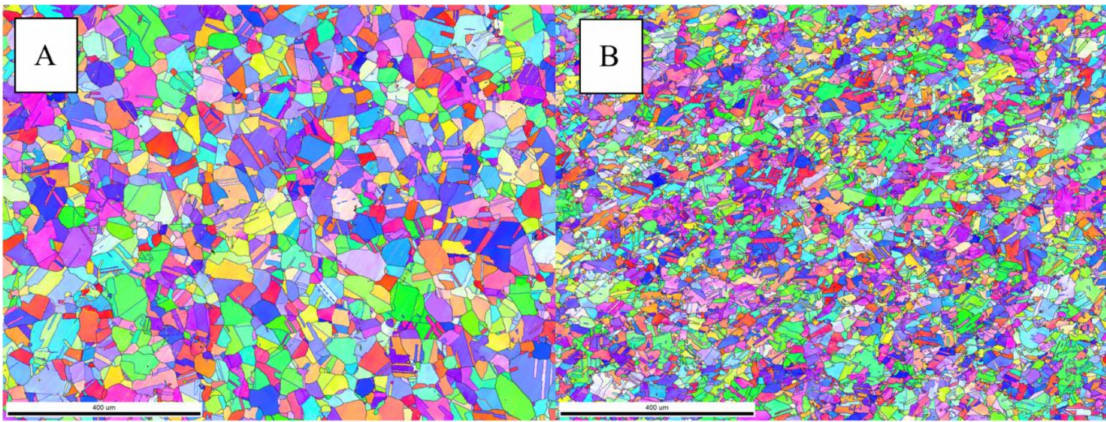
Figure 3. Electron backscatter diffraction (EBSD) inverse pole figure (IPF) maps of microstructures ( A , B